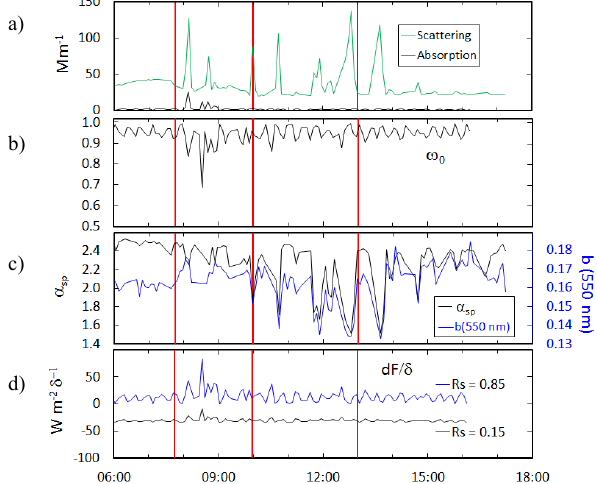
Fig. 12. Backscatter fraction b at λ = 550nm vs. Ångström expo- nent of scattering ( α sp ) in the aerosol cottage before the flaming phase and after the last plume was observed (crosses), during the flaming phase (red circles), and during the smoldering phase (grey circles). The regression line was fitted with the smoldering-phase